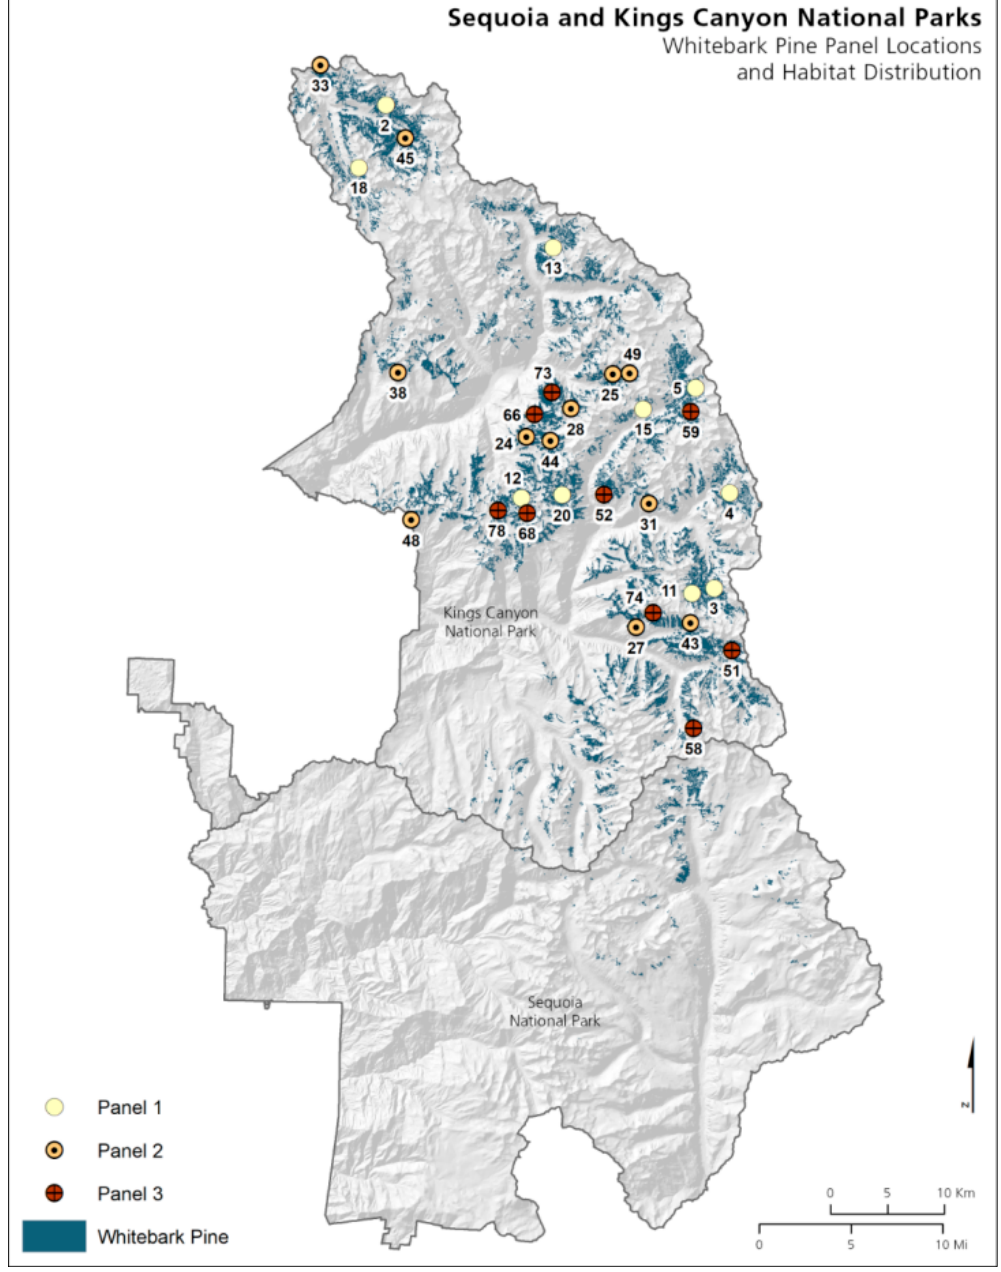
Figure 5. Whitebark pine distribution and plot locations in Sequoia and Kings Canyon National Parks, CA, USA. Plots are assigned to one of three panels (12 plots each) and are sampled using a rotating re-visit design. Thirty-one of the planned 36 plots had been installed at time of publication.